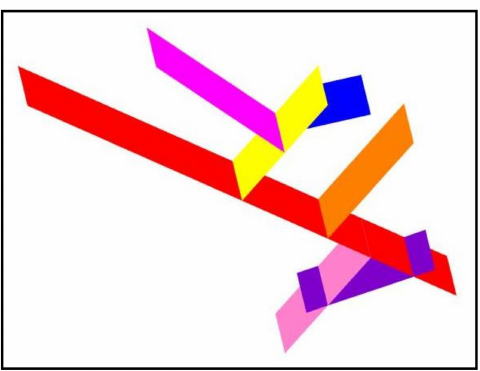
Figure 20. Schematic diagram of the results of complex fault model